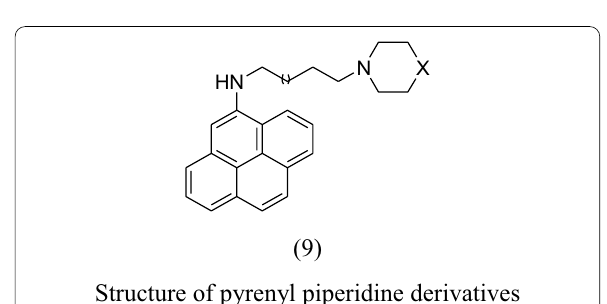
Fig. 17 Structure of pyrenyl piperidine